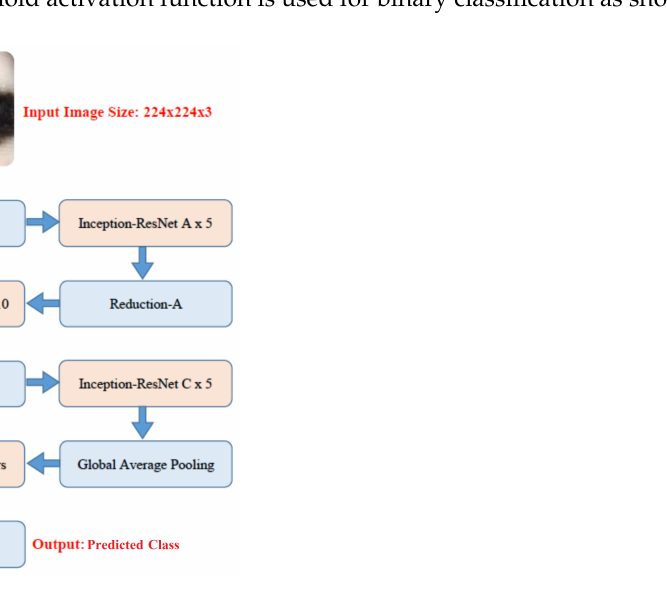
Figure 4. The fine-tuning of proposed method of pre-trained Inception-ResNet-V2 architecture.